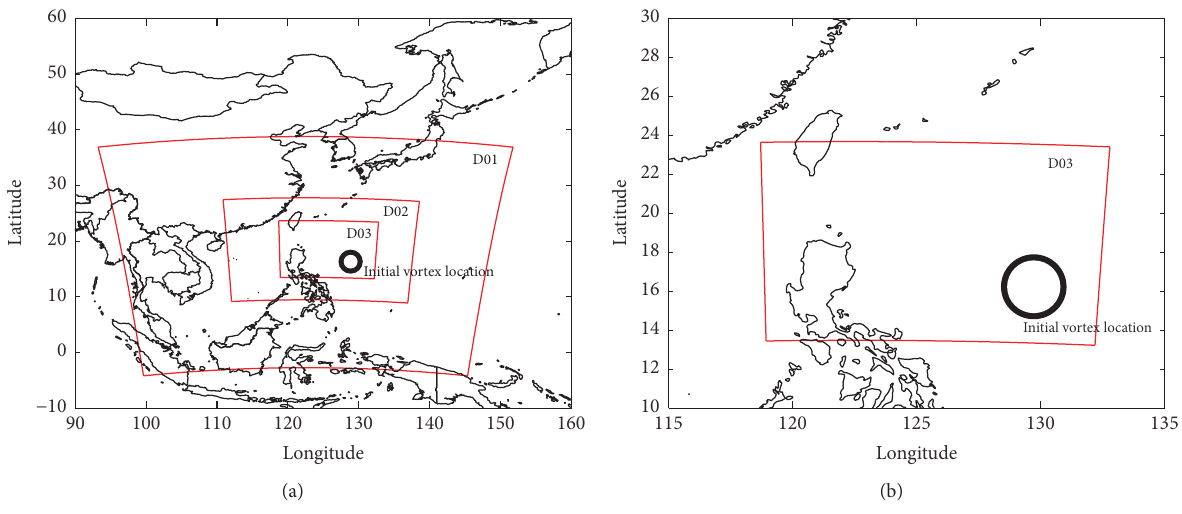
Figure 1: WRF domains: (a) all the domains; (b) D03.